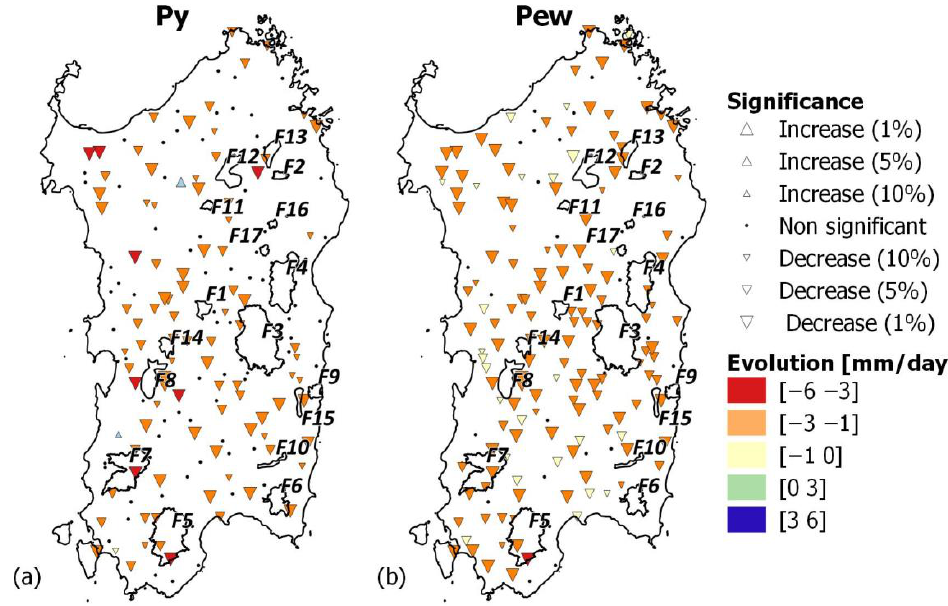
Figure 3. Precipitation trends at the Sardinian rain stations for the period 1922‒2019 (the Theil‒Sen slope values (mm/y) with levels of significance ( p -values (%)) at the yearly scale ( a ) and for the extended winter season ( b )).